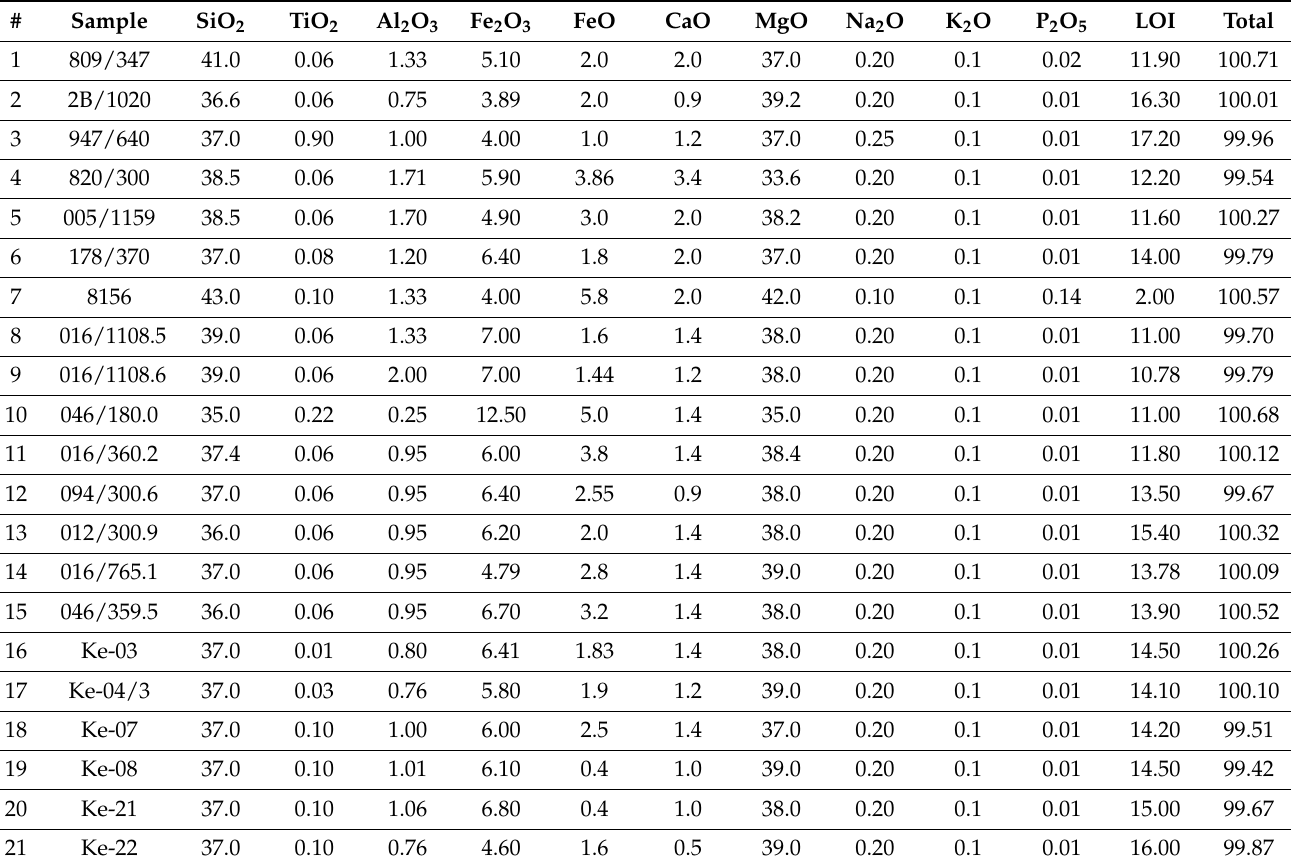
Table 1. Bulk rock composition of Kempirsay peridotites